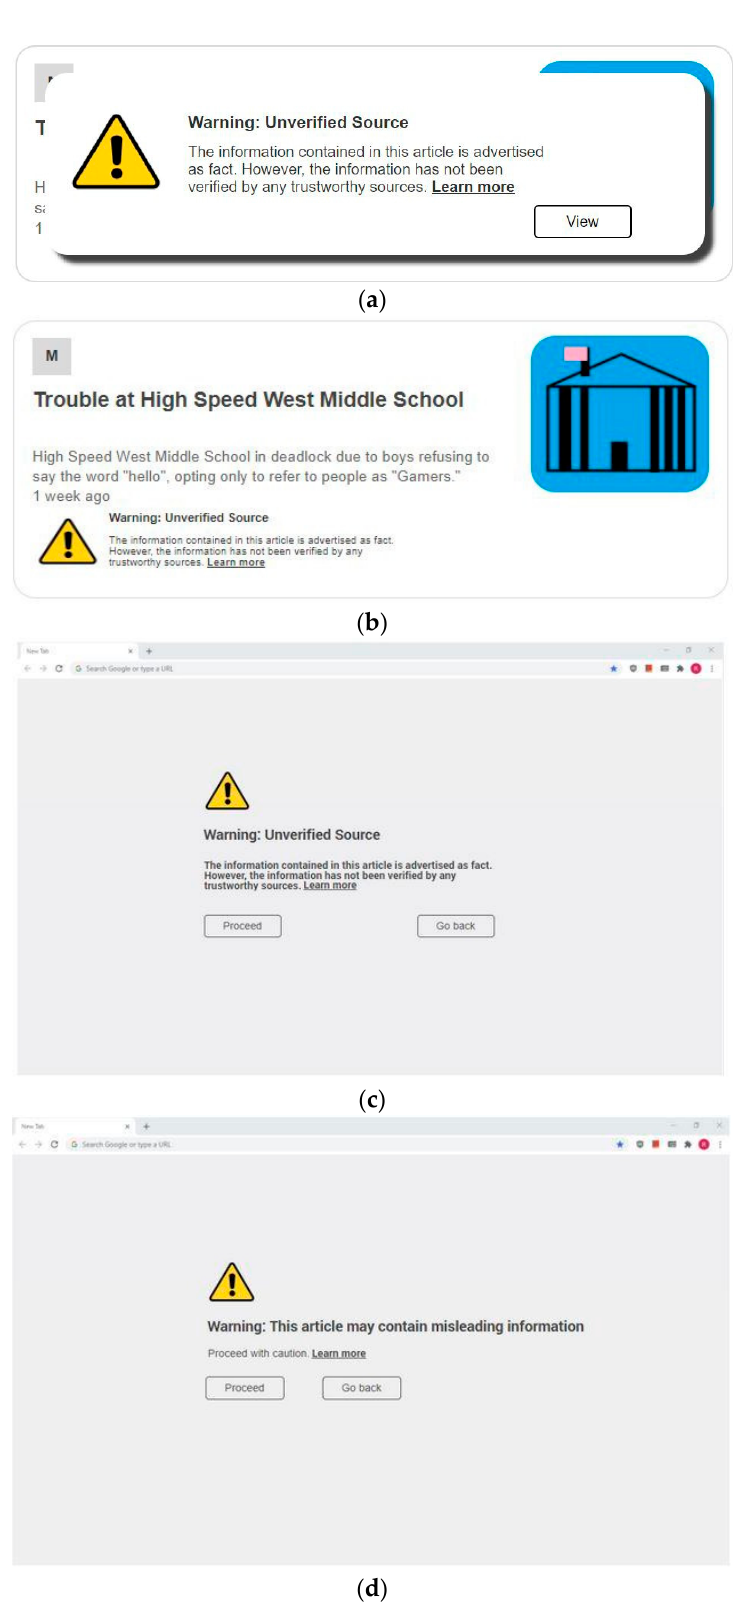
Figure 14. Example of a warning label: ( a ) Label 6—replacement without context; ( b ) Label 7—supplemental with context; ( c ) Label 8—intermediary without context; ( d ) Label 9—intermediary without context simplified.